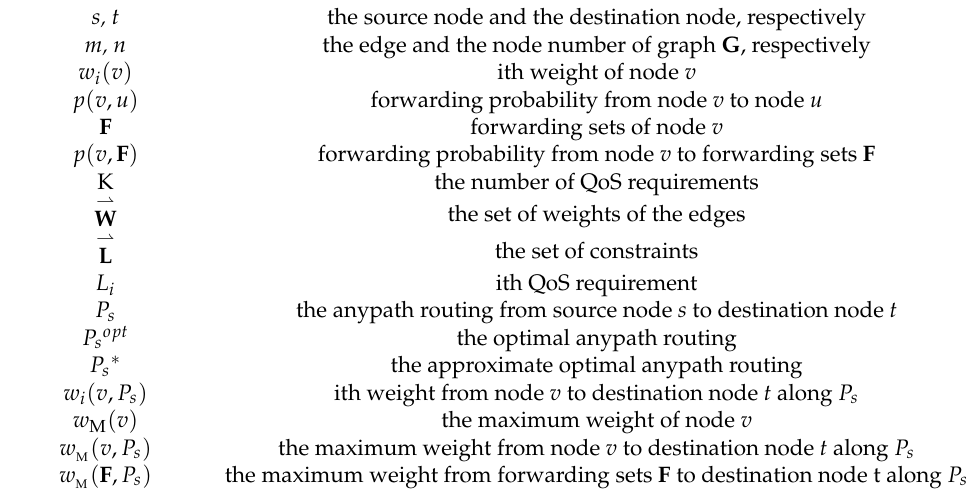
Table 1. Frequently used